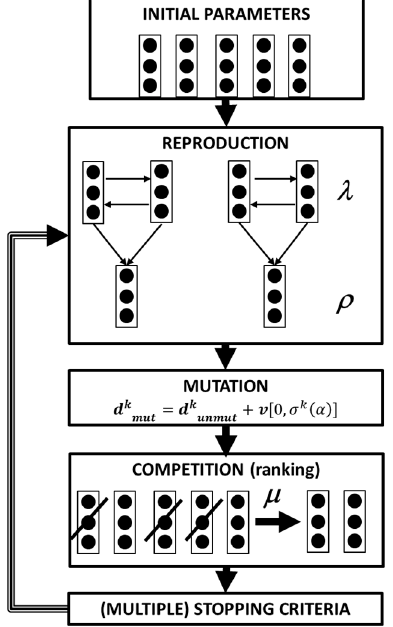
Figure 11. Flowchart for the ( µ / ρ ; λ ) strategy .